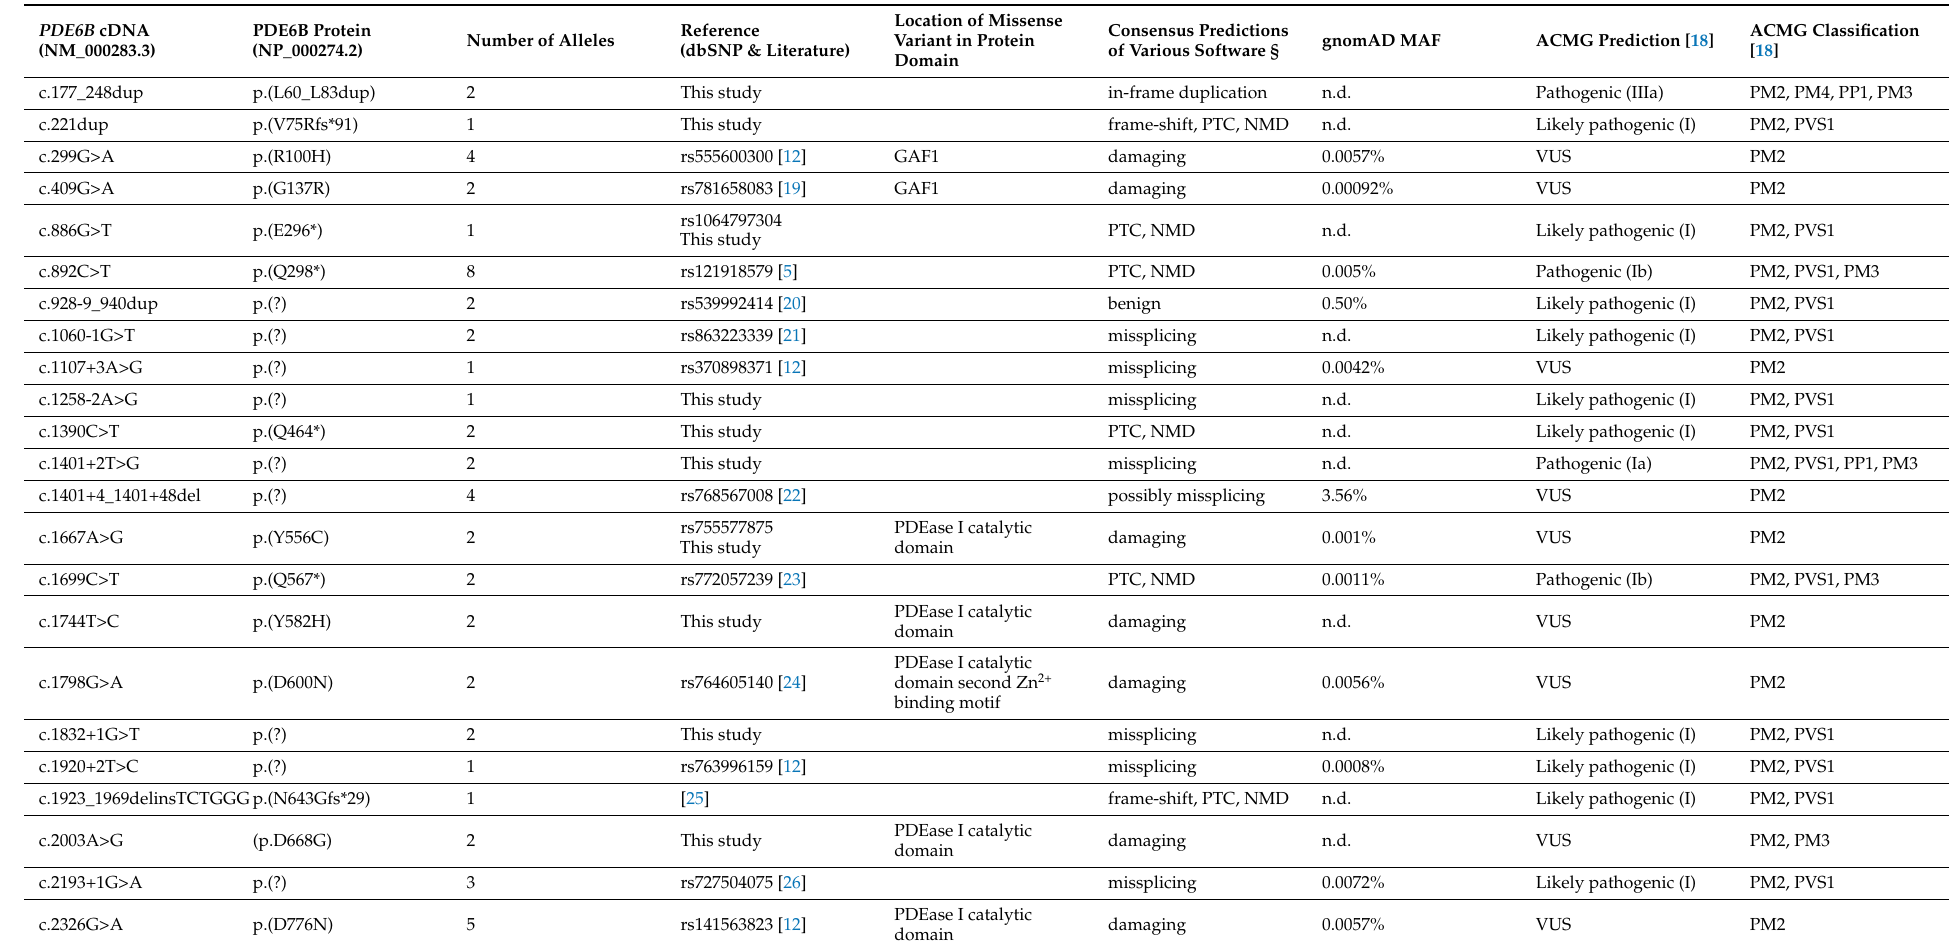
Table 2. Mutation spectrum in PDE6B and the number of alleles in this